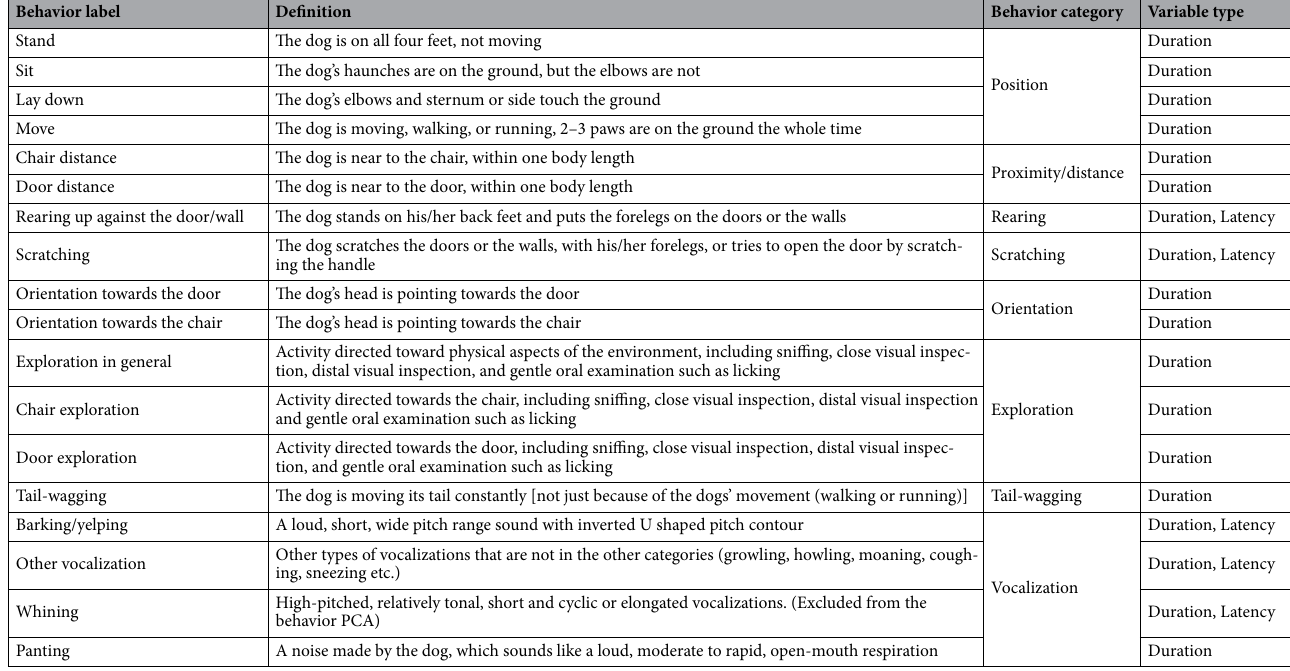
Table 4. The description of the coded behaviors of the separation test (we used the same coding as Marx et al. 26